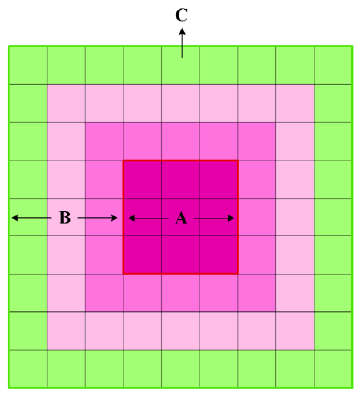
Figure 1. Distribution of different types of pixels in the ground object (A: pixels far from the boundary of the object, B: pixels near the boundary of the object, and C: mixed pixels at the boundary). The difference in pixel color represents the difference between the features of the pixels.